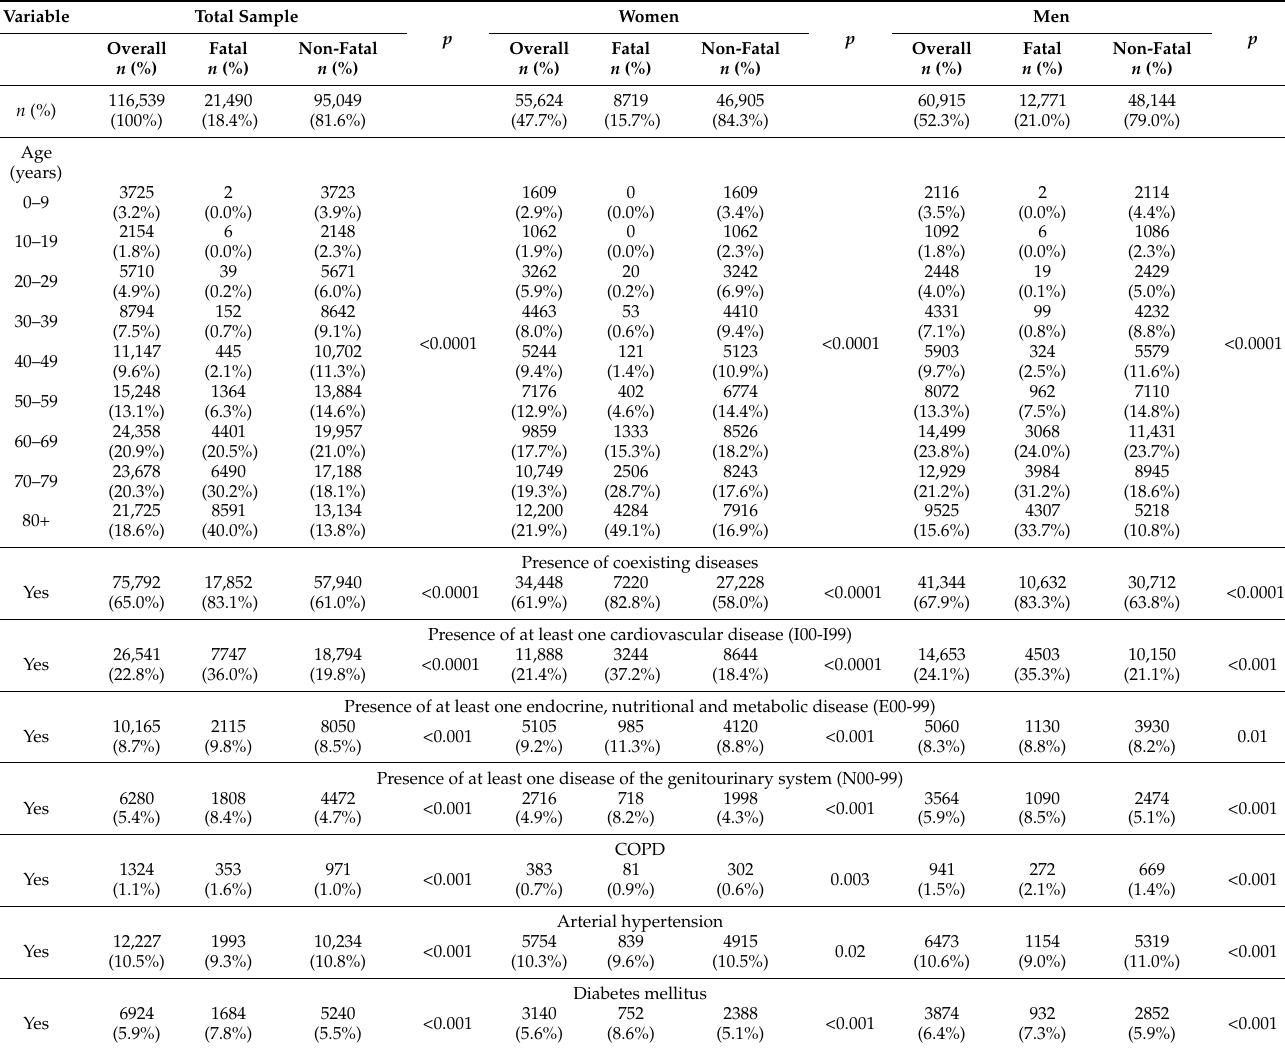
Table 1. Characteristics of 116,539 patients hospitalized with COVID-19 by sex, Poland, March–December